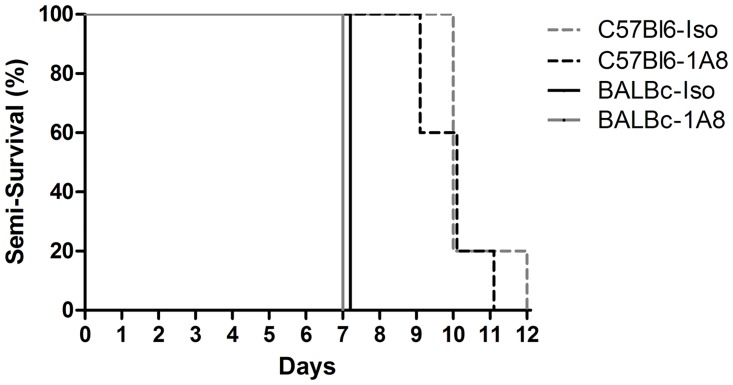
Semi-survival experiment.Kaplan-Meier curves showing the percentages of BALBc mice (solid lines) and C57Bl6 mice (dashed lines) treated with either 1A8 mAb (black, N = 5-6/group) or isotype control antibody (grey, N = 5-6/group) reaching the end point of a clinical score of ≥ 4 and/or > 20% weight loss after PVM inoculation (not significant).